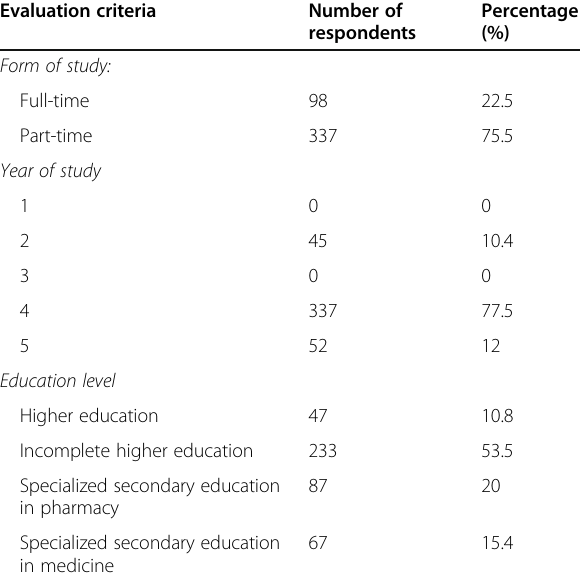
Table 1 Educational characteristics of 435 pharmacy students at the Ukrainian Bogomolets National Medical University who answered a questionnaire about medical cannabis during